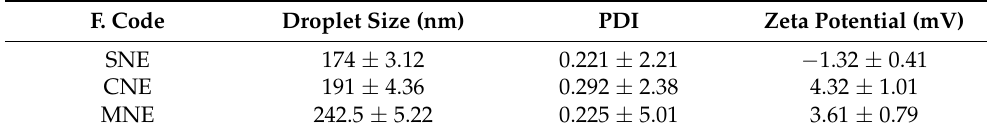
Table 2. Droplet size, polydispersity index (PDI) and Zeta potential of formulations. F.